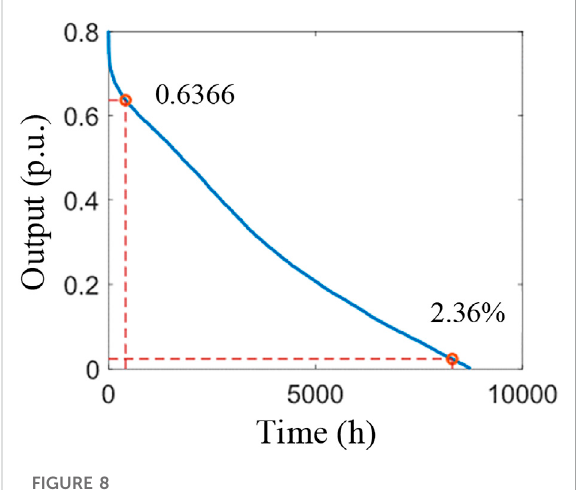
FIGURE 8 Descending order of hourly output in 2019.